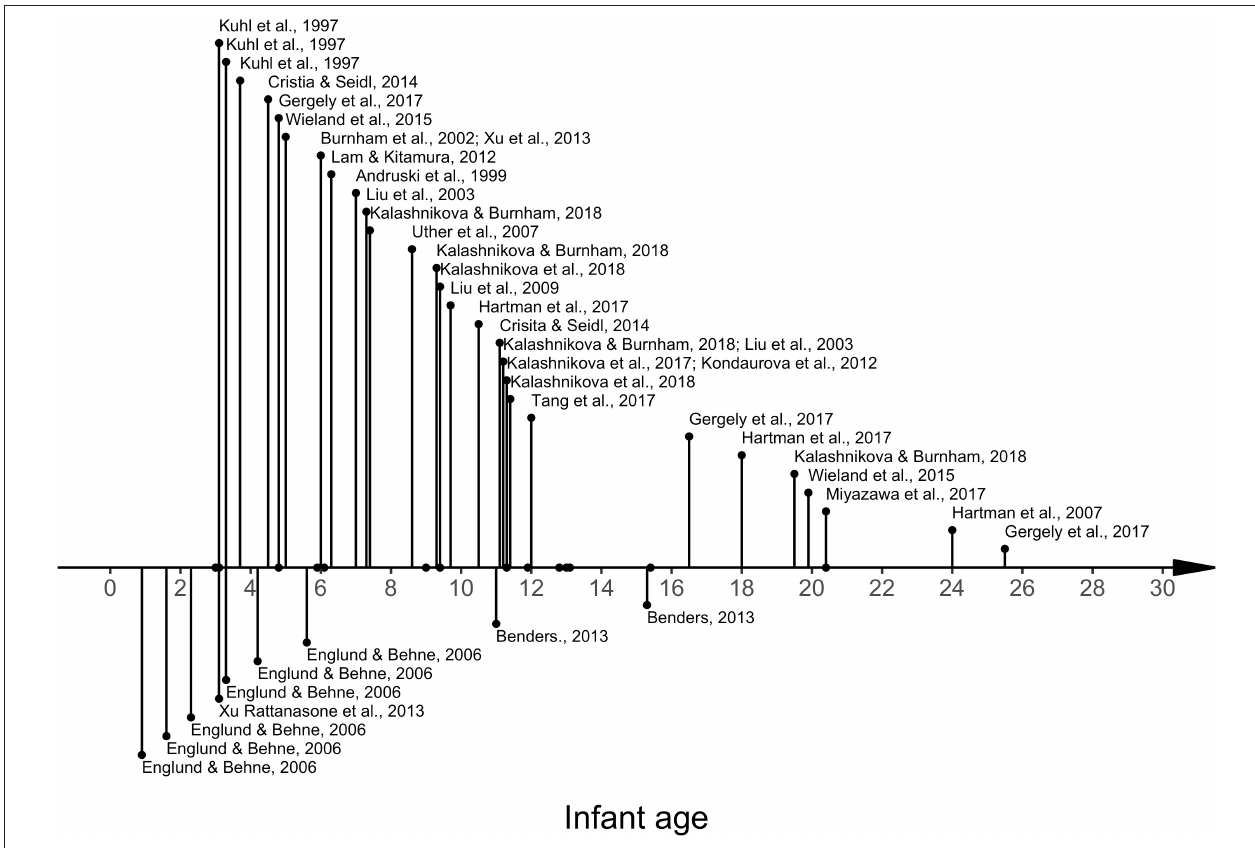
FIGURE 1 | VHH in IDS vs. in ADS by infant age. X-axis: Infant age in months. Listed above the x-axis are studies reporting ages at which IDS has been found to be more hyperarticulated than in ADS, below the x-axis are listed studies reporting ages at which IDS has been found to be more hypoarticulated than ADS. Note that the length of the line does not indicate strength of hypo- or hyperarticulation. Dots on the x-axis show ages at which no difference in VHH between IDS and ADS has been reported (Dodane and Al-Tamimi, 2007; Kondaurova et al., 2012; Xu Rattanasone et al., 2013; Burnham et al., 2015; Wieland et al., 2015; Kalashnikova and Burnham,